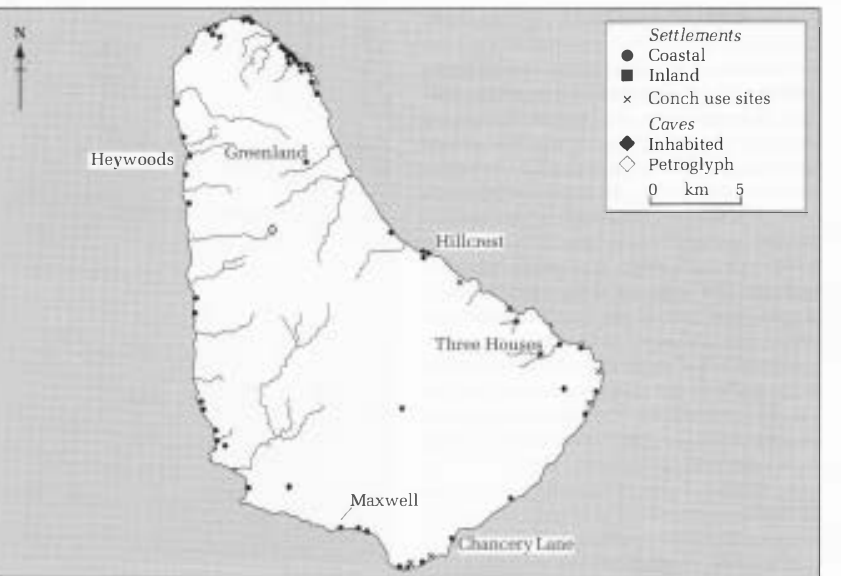
Figure 7 Barbados: distribution of prehistoric sites. Sites mentioned in the text are